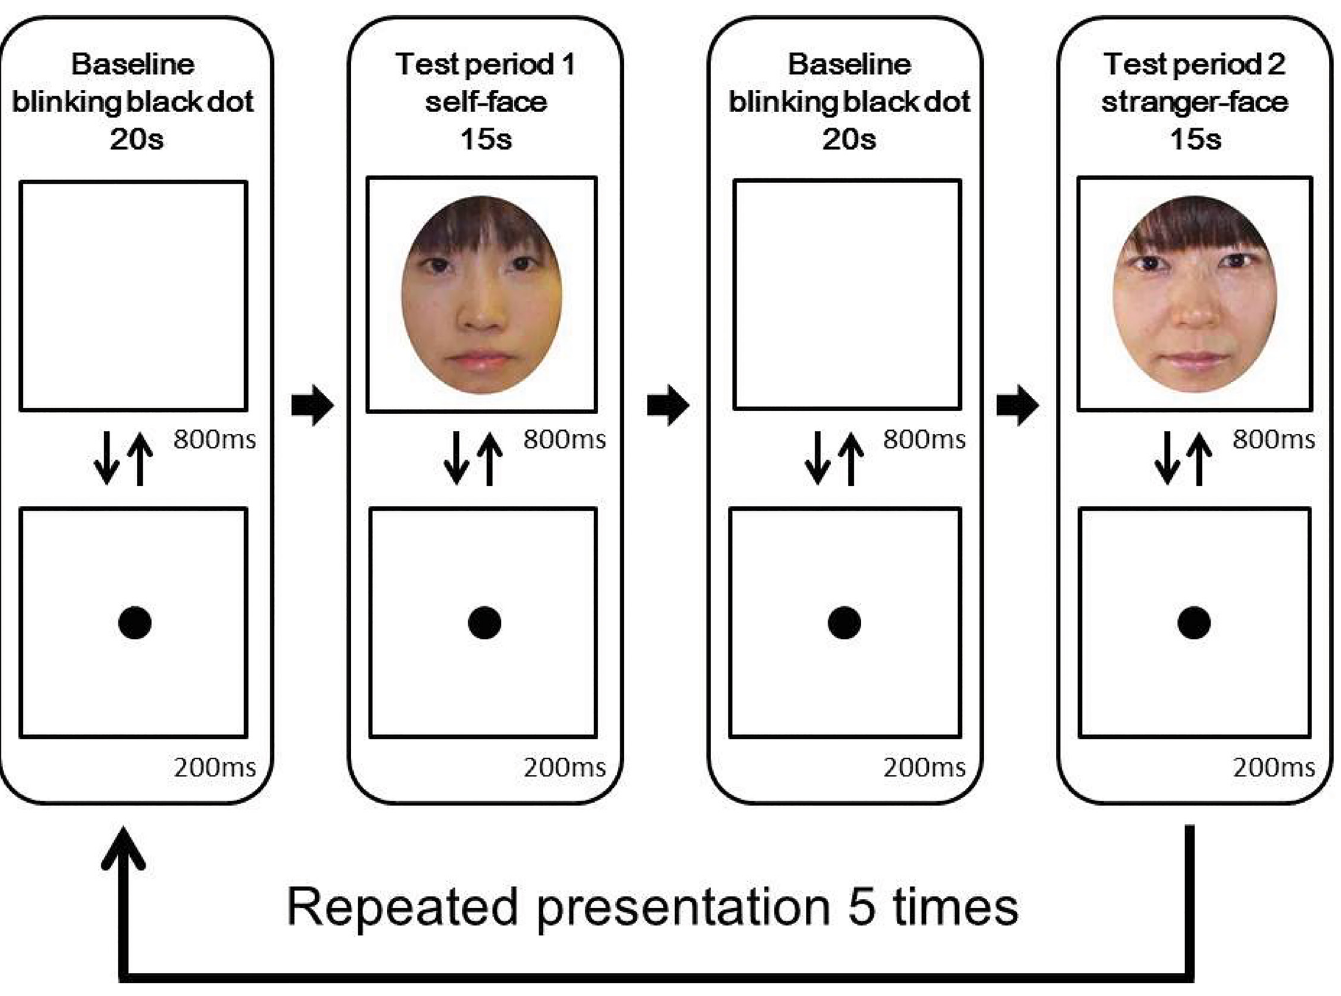
Fig 1. Experimental procedure. In each trial, the baseline phase consisted of visual stimuli presenting images of a black dot, and its duration was fixed at 20s. The test phases consisted of self-face and stranger-face visual stimuli. The duration of each test period was 15s. The presentation order of test phases 1 and 2 was alternated for each